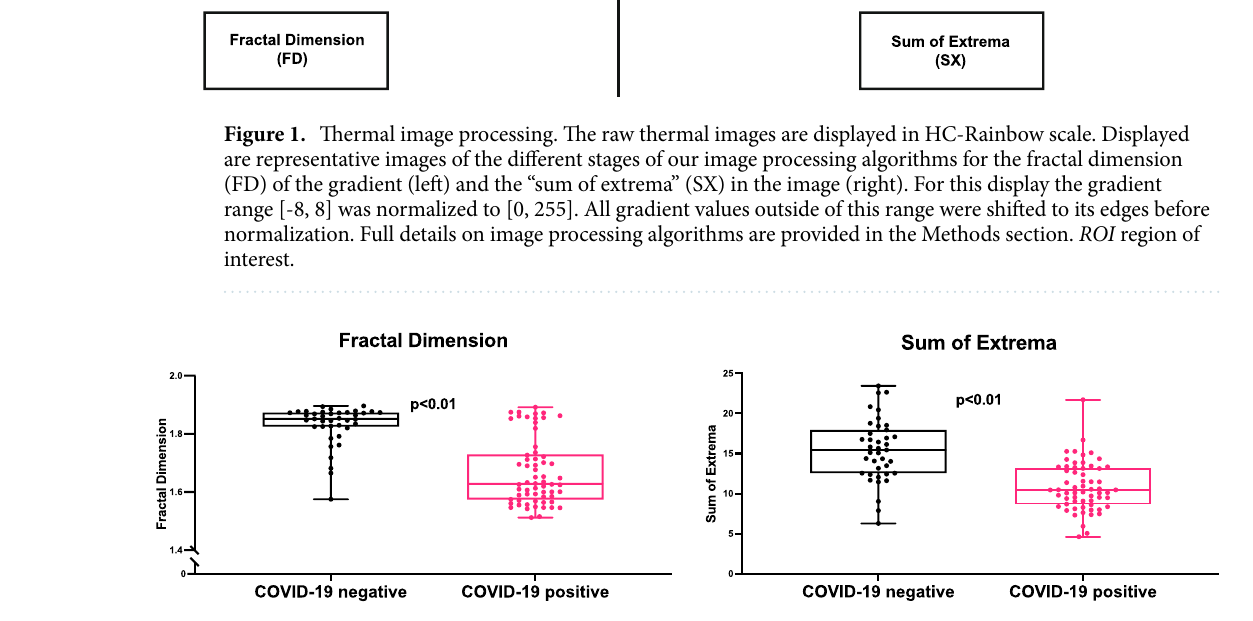
Figure 2. Thermal imaging scores according to COVID-19 disease status. Box plots with individual values of fractal dimension (FD) (left side) and sum of extrema (SX) (right side) scores. Patients who were COVID-19 positive had lower thermal scores compared to COVID-19 negative individuals. P value by unpaired